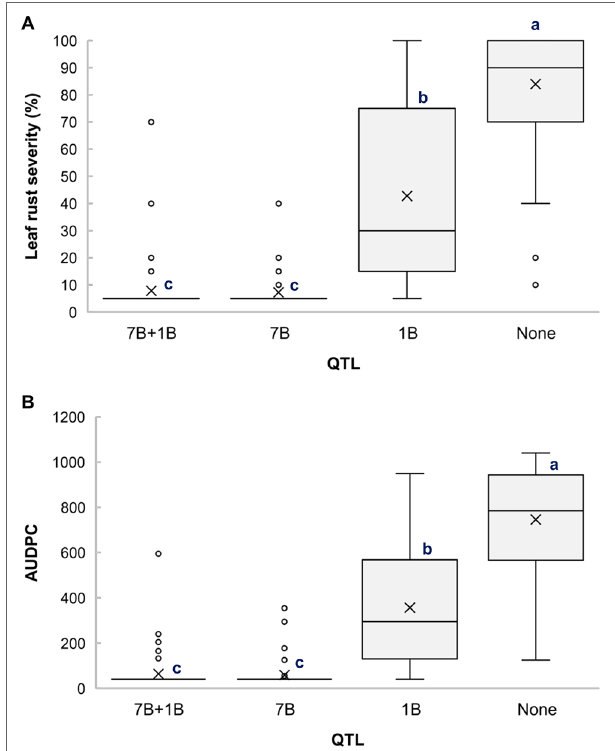
FIGURE 3 | Boxplots illustrating the effects of QLr.usw-7BL and QLr.usw- 1BL.1 on (A) LRS and (B) AUDPC in the Arnacoris/ATRED #2 population. The QTL effects are shown in isolation and in combination. Means with the same letter are not significantly different from one another at P < 0.05.